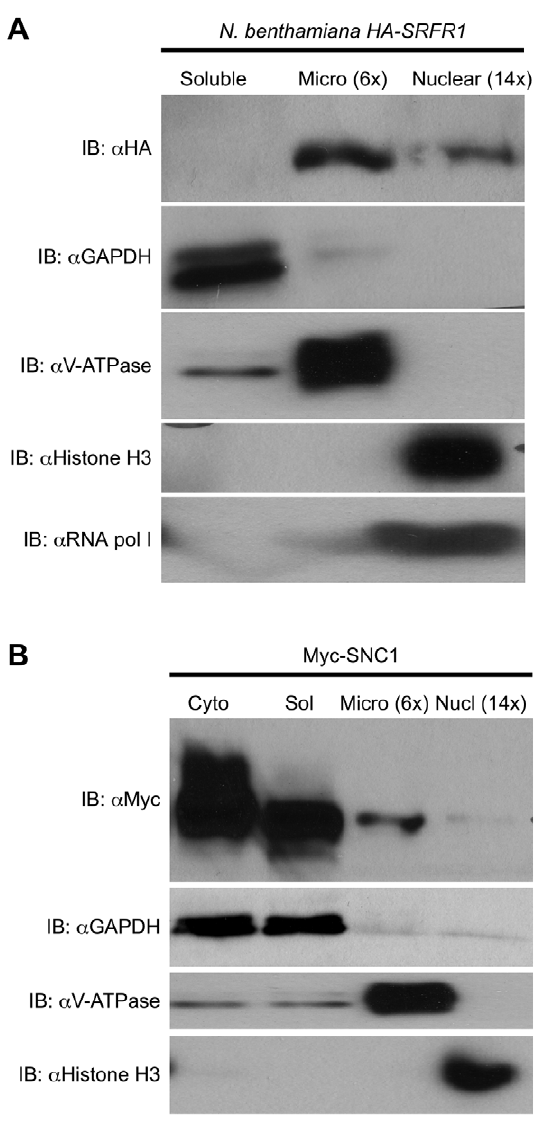
Figure 8. Localization of SRFR1 and SNC1 expressed in N. benthamiana . (A) HA-SRFR1 stably expressed in transgenic N. benthamiana localizes to the cytoplasmic microsomal and nuclear fractions. (B) Transiently expressed Myc-SNC1 localizes predominantly to the soluble cytoplasmic fraction, with detectable amounts in the microsomes and nuclei. In (A) and (B), the microsomal and nuclear fractions are 6 and 14 times concentrated, respectively, compared to the soluble fraction. The degree of fraction enrichment was determined using antibodies against marker proteins (anti-histone H3 and anti-RNA polymerase I subunit, nucleus; anti-GAPDH, cytoplasmic soluble; and anti-V-ATPase, microsomes). Each assay was repeated at least three times with similar